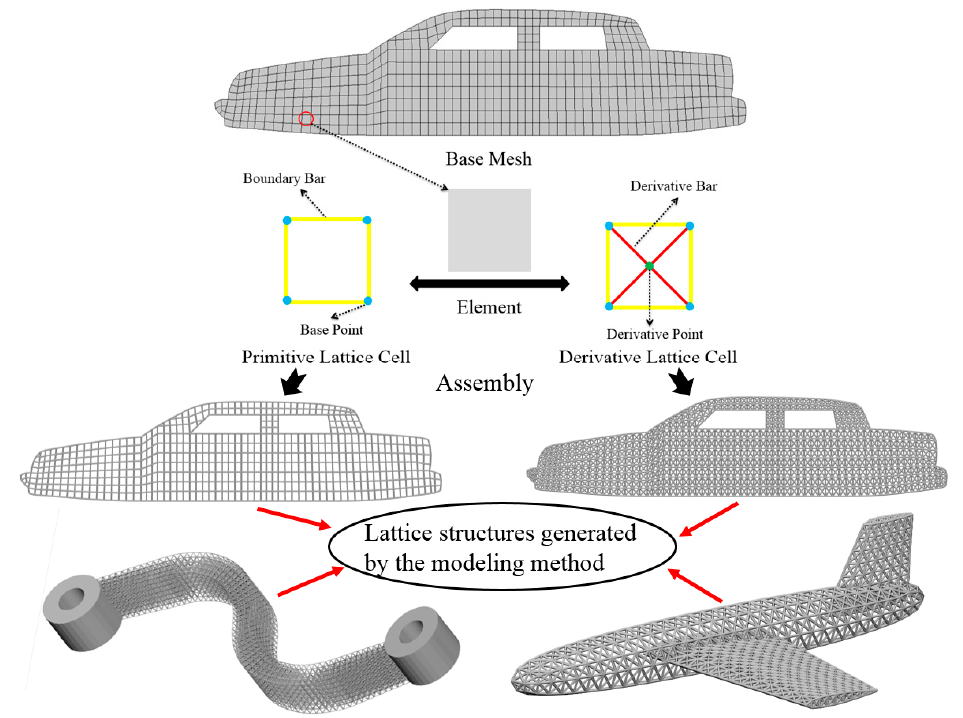
Figure 1. Procedure of the modeling method and some lattice examples.